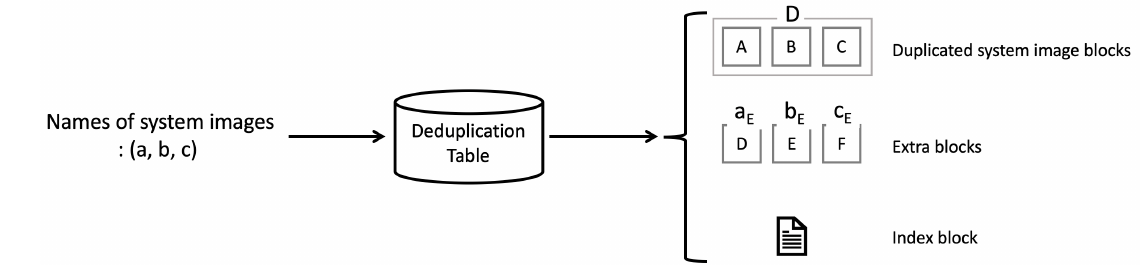
Figure 10. Input and output of the deduplication